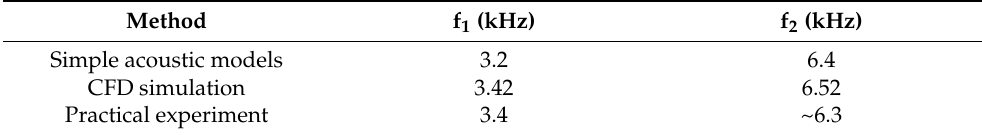
Table 1. Estimated resonant frequency of Pitot